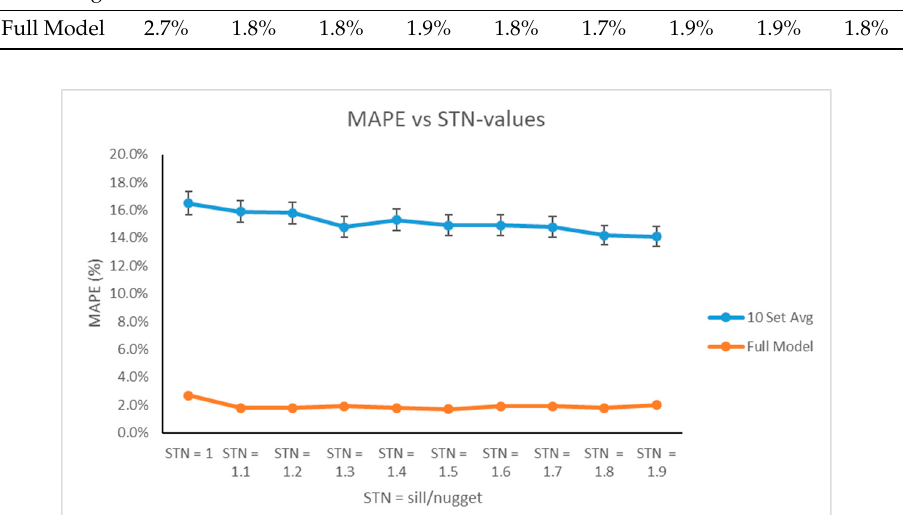
Figure 4. Mean Absolute Prediction Error Values from the Cross-Validation Procedure.